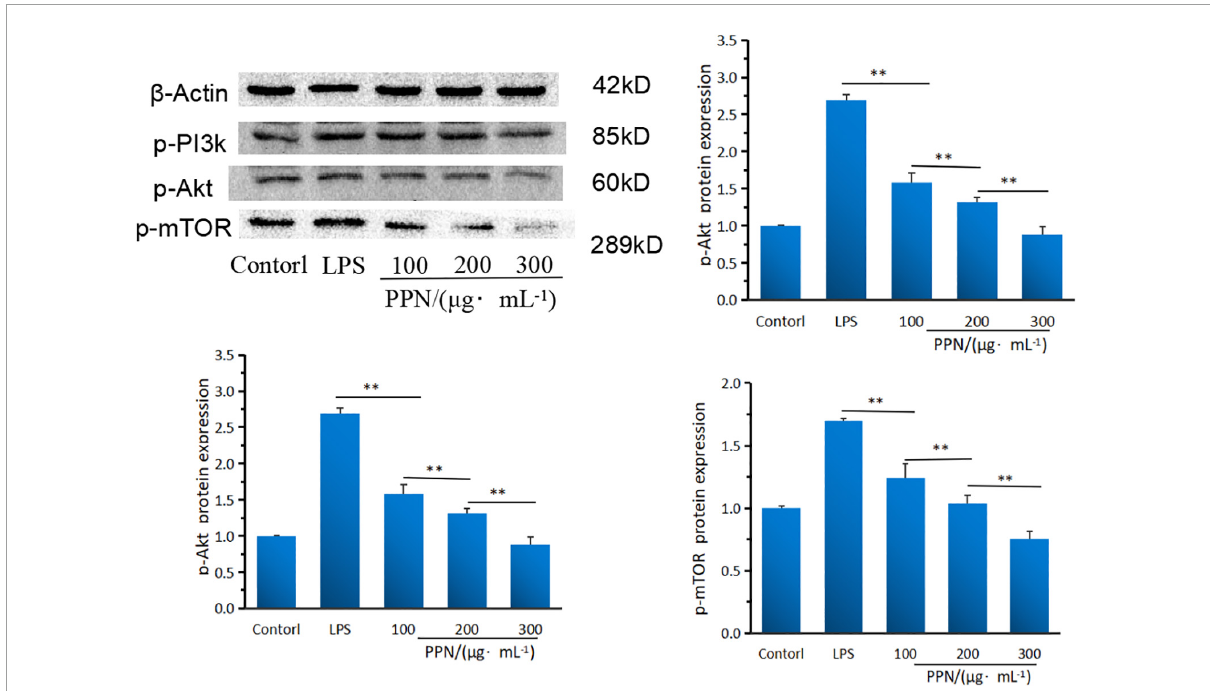
FIGURE8 The PI3KAktmTOR protein expression of SPN and PPN. **Indicates p <